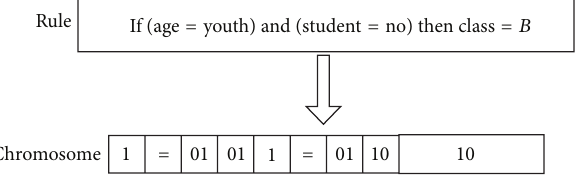
Figure 4: Chromosome construction.